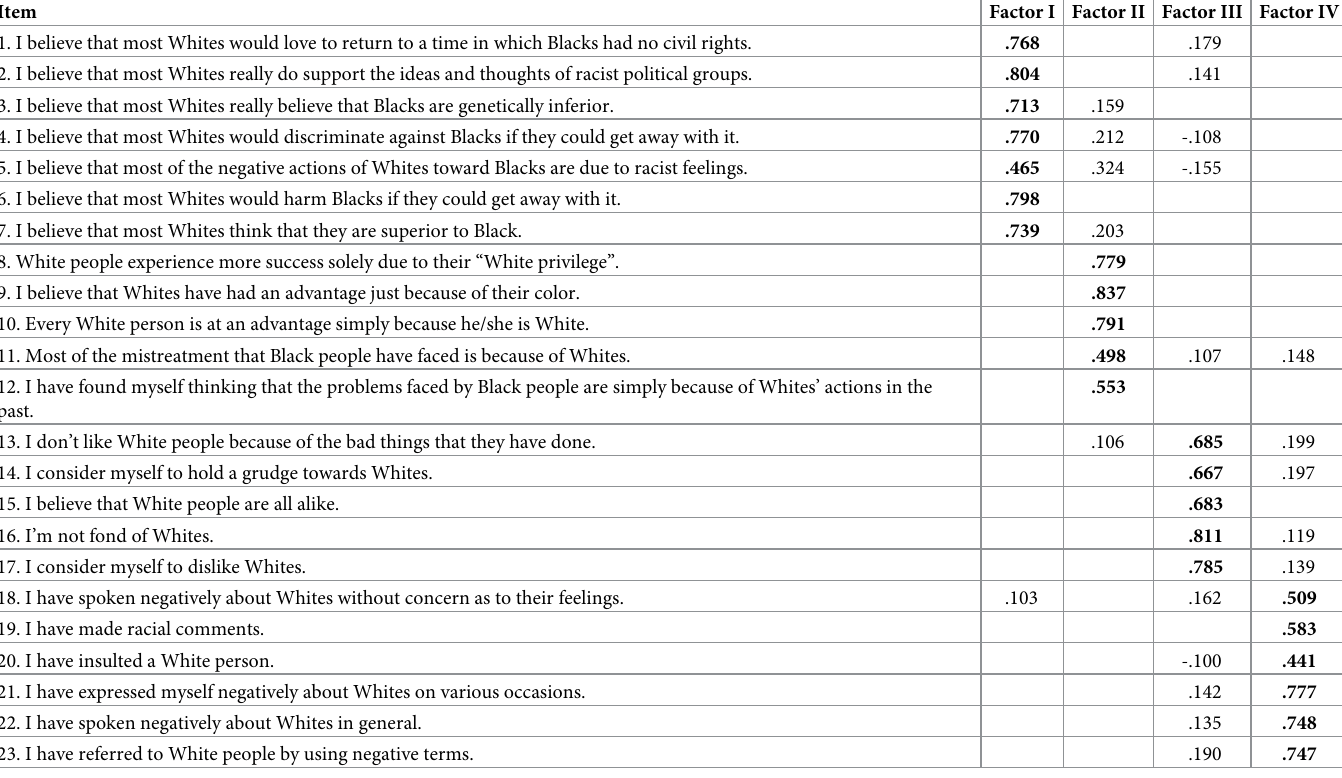
Table 4. Summary of ESEM results (standardized factor loadings and item content) for final version of our AWB measure (Study 2).